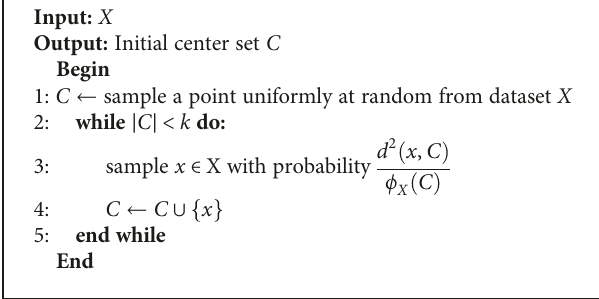
Algorithm 2: ( K -means++